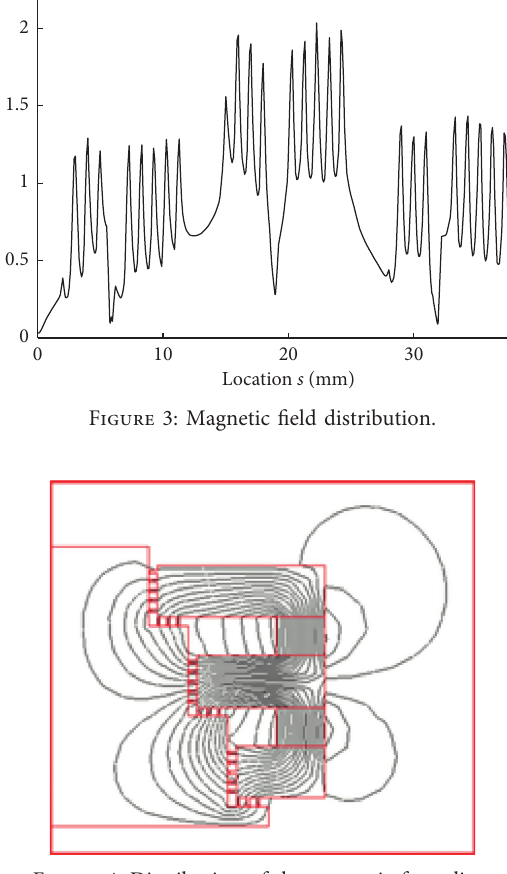
Figure 4: Distribution of the magnetic force line.